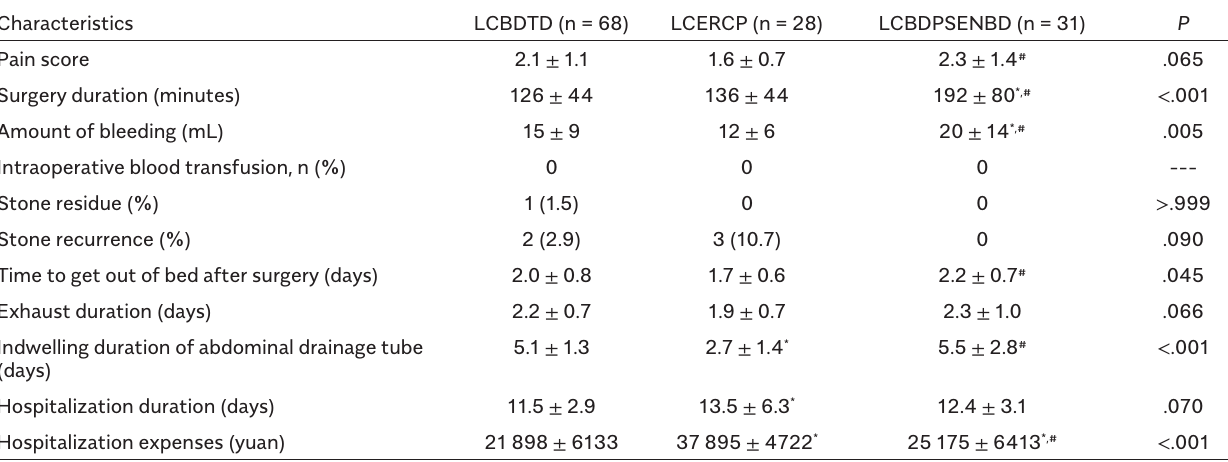
Table 3. Comparison of the Recovery of Patients with Different Surgical Treatments